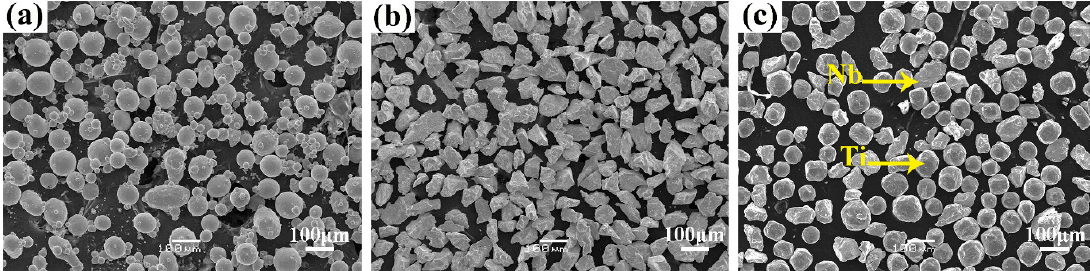
Figure 1. Scanning electron microscope (SEM) images of feedstock powders: ( a ) pure Ti; ( b ) pure Nb; and ( c ) Ti–26Nb powder mixture.